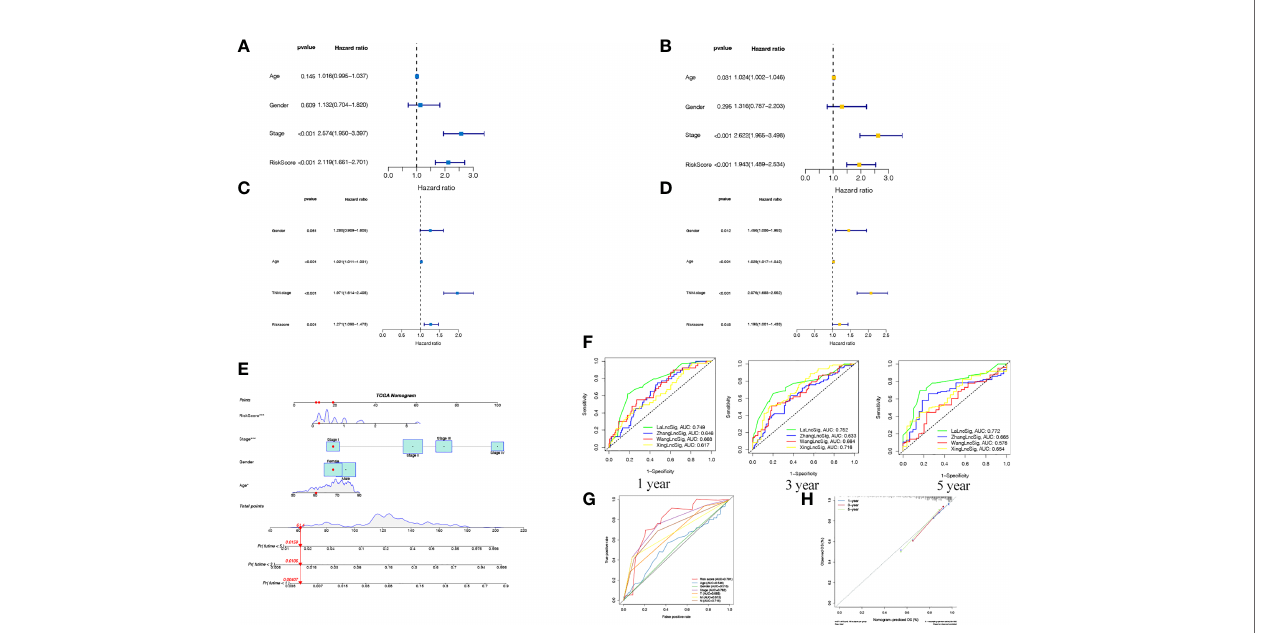
FIGURE 4 | Cox analysis in TCGA (A univariate B multivariate ) and GEO (C univariate D multivariate ) showed that the signature was an independent risk factor for COAD patients. (E) A nomogram established regarding the risk score and clinicopathological charateristics. (F) ROC curves of laRlncRNA pairs-based signature at 1, 3, 5-year compared with three other lncRNA-based signature studies on COAD patients. (G) The AUC values of the risk score and clinicopathological features. (H) Calibration plot to depict the consistence between the predicted and the actual OS at l, 3, 5